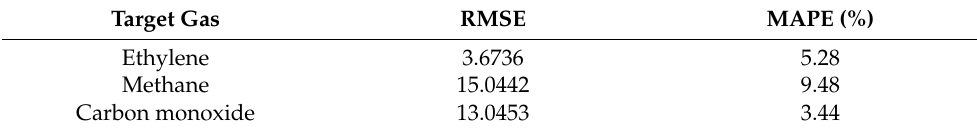
Table 11. Overall prediction effect of the PSO-LSSVM model on turbulent gas mixtures.